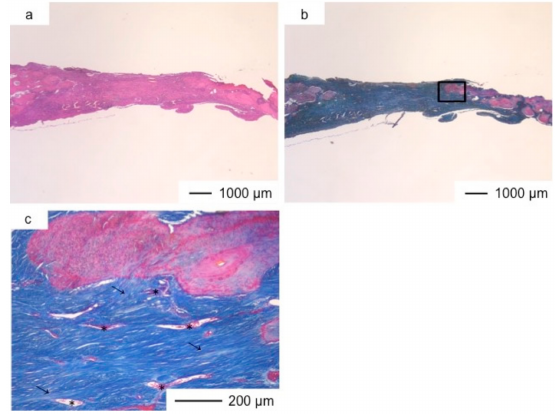
Figure 7. Light microscopic images of ChGCa_HAp in cranioplasty two years after implantation, stained by HE ( a ) and AM ( b ); ( c ) Magnification of the inset in ( b ).